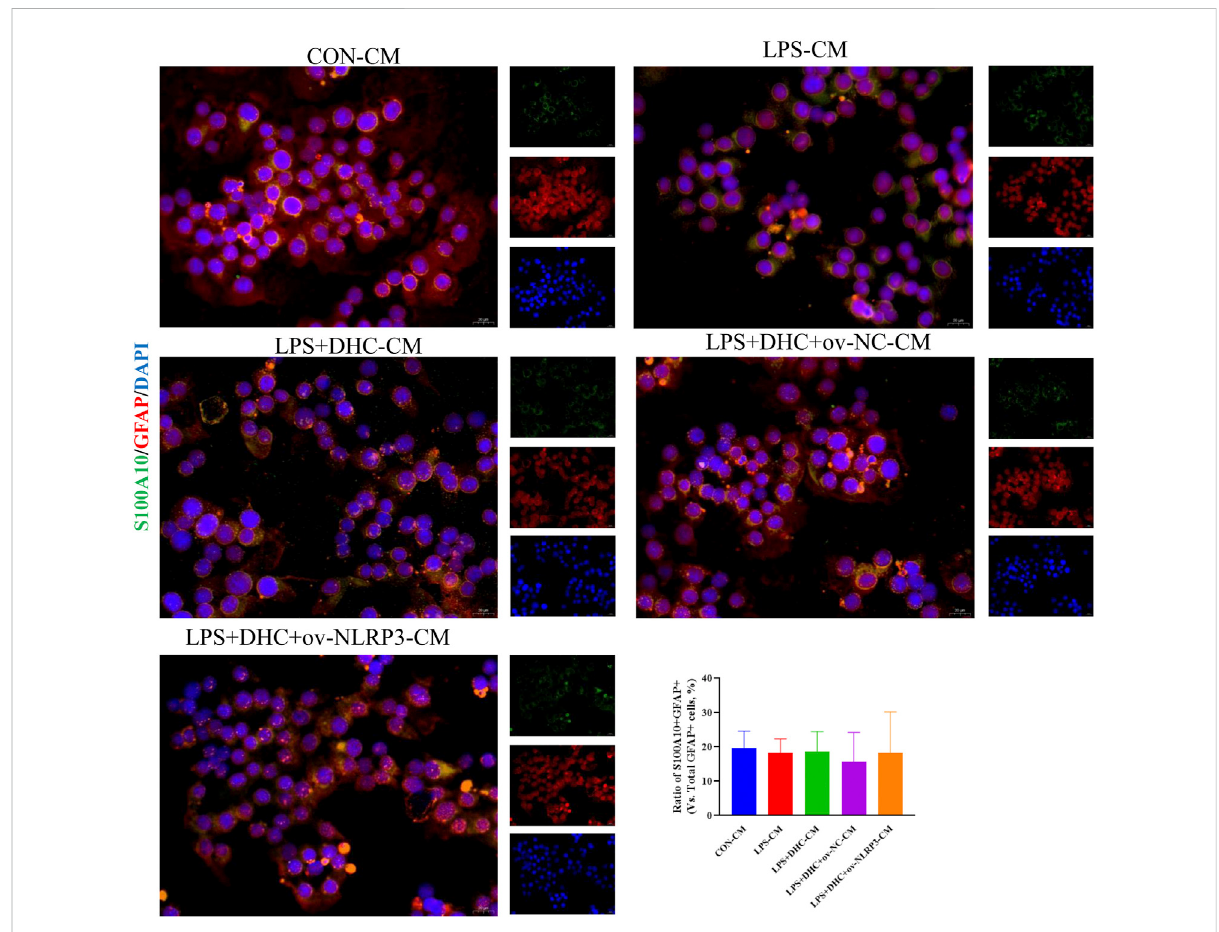
FIGURE 11 Effects of microglia-conditioned medium on astrocyte activation. BV2 cells were incubated with DHC (100 mg/L) and 100 ng/ml LPS for 12 h ov-NC or ov-NLRP3 plasmid was transfected into BV2 cells 6 h before LPS induction. Conditioned media of microglia were collected from each group, followed by intervention of astrocytes for 24 h. The astrocytes were subjected to immuno fl uorescent staining with S100A10 (green), GFAP (red), and DAPI